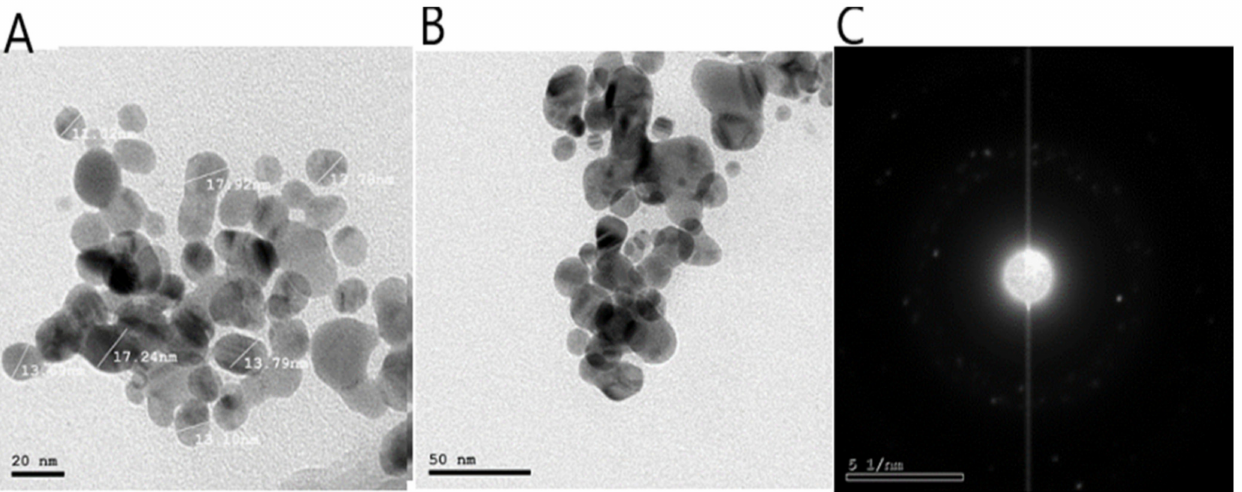
Figure 4. HR-TEM micrographs of the biosynthesized AgNPs using GTLE; ( A ): at 20 nm, ( B ); at 50 nm, ( C ): SAED confirmed the crystalline nature of the formed AgNPs.